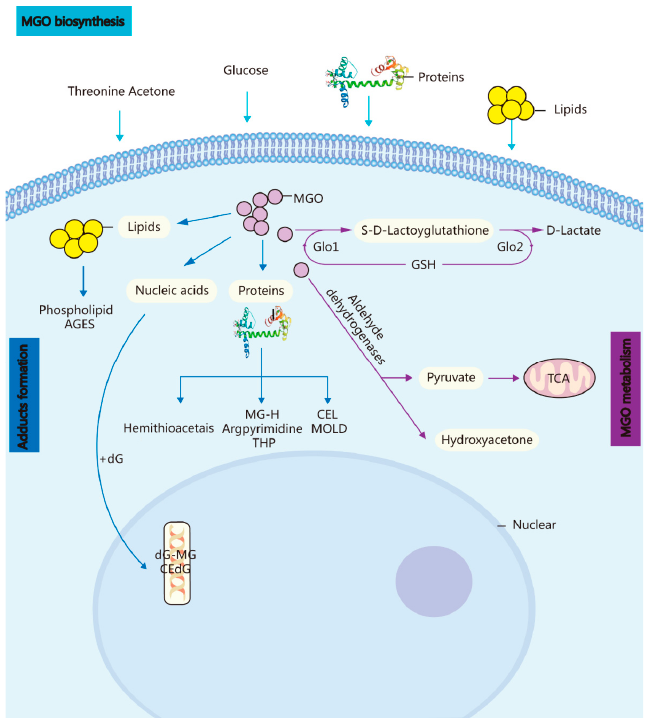
Figure 1. Biosynthesis, metabolism, and adduct formation in MGO. MGO biosynthesis: MGO is an unavoidable endogenous coproduct of the metabolism of glucose, threonine acetone, lipids, and proteins. Adduct formation: The incubation of these highly reactive compounds with proteins, lipids, and nucleic acids leads to the rapid formation of AGEs and advanced lipoxidation end-products. MGO metabolism: MGO is converted into S-D-lactoylglutathione in the GSH-dependent GLO1 system and subsequently transformed into D-lactate via GLO Methylglyoxal reductase and aldehyde dehydrogenase convert MGO into hydroxyacetone or pyruvate.